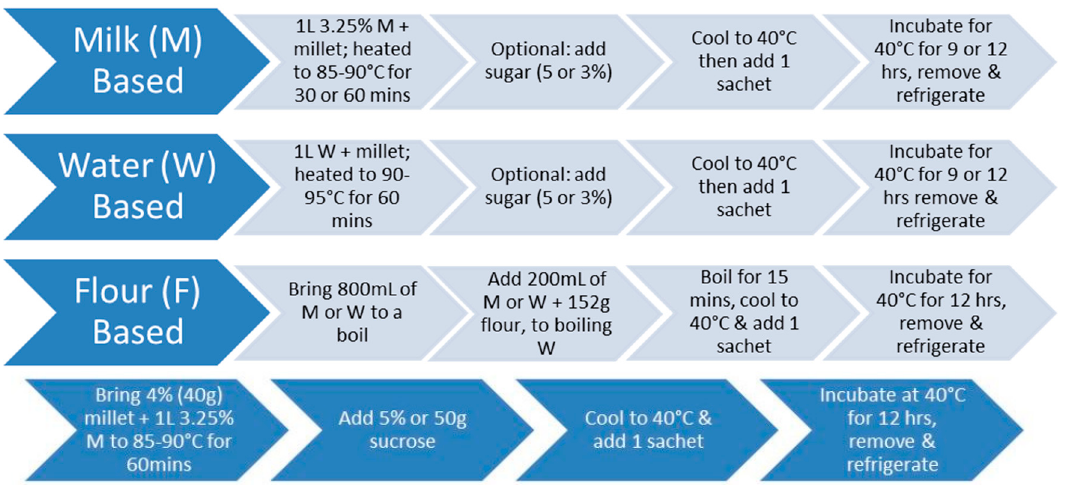
Figure 1. ( top ): Optimized preparation method for flour/milk/water based fermented millet products; ( bottom ): optimized recipe for 4% millet in milk, 60-min pre-treatment, 12 h of fermentation.